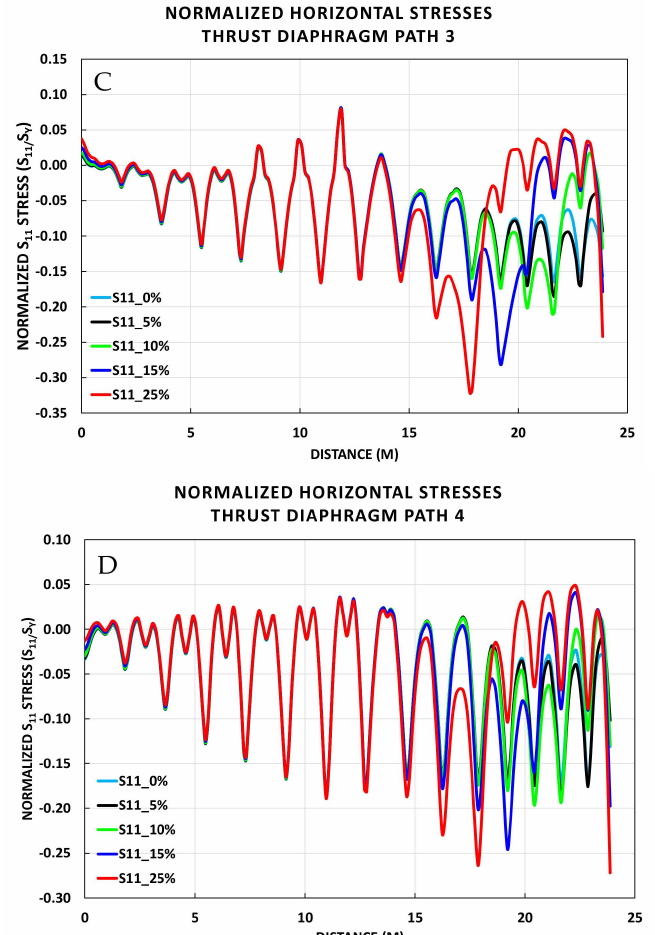
Figure 13. Horizontal stresses in thrust diaphragm along vertical paths 1, 2, 3, and 4, on plots ( A ), ( B ), ( C ), and ( D ),